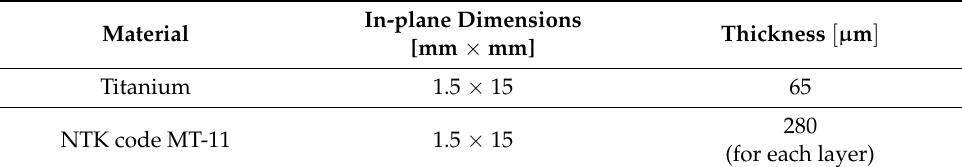
Table 5. Geometrical features of the cantilever beam.